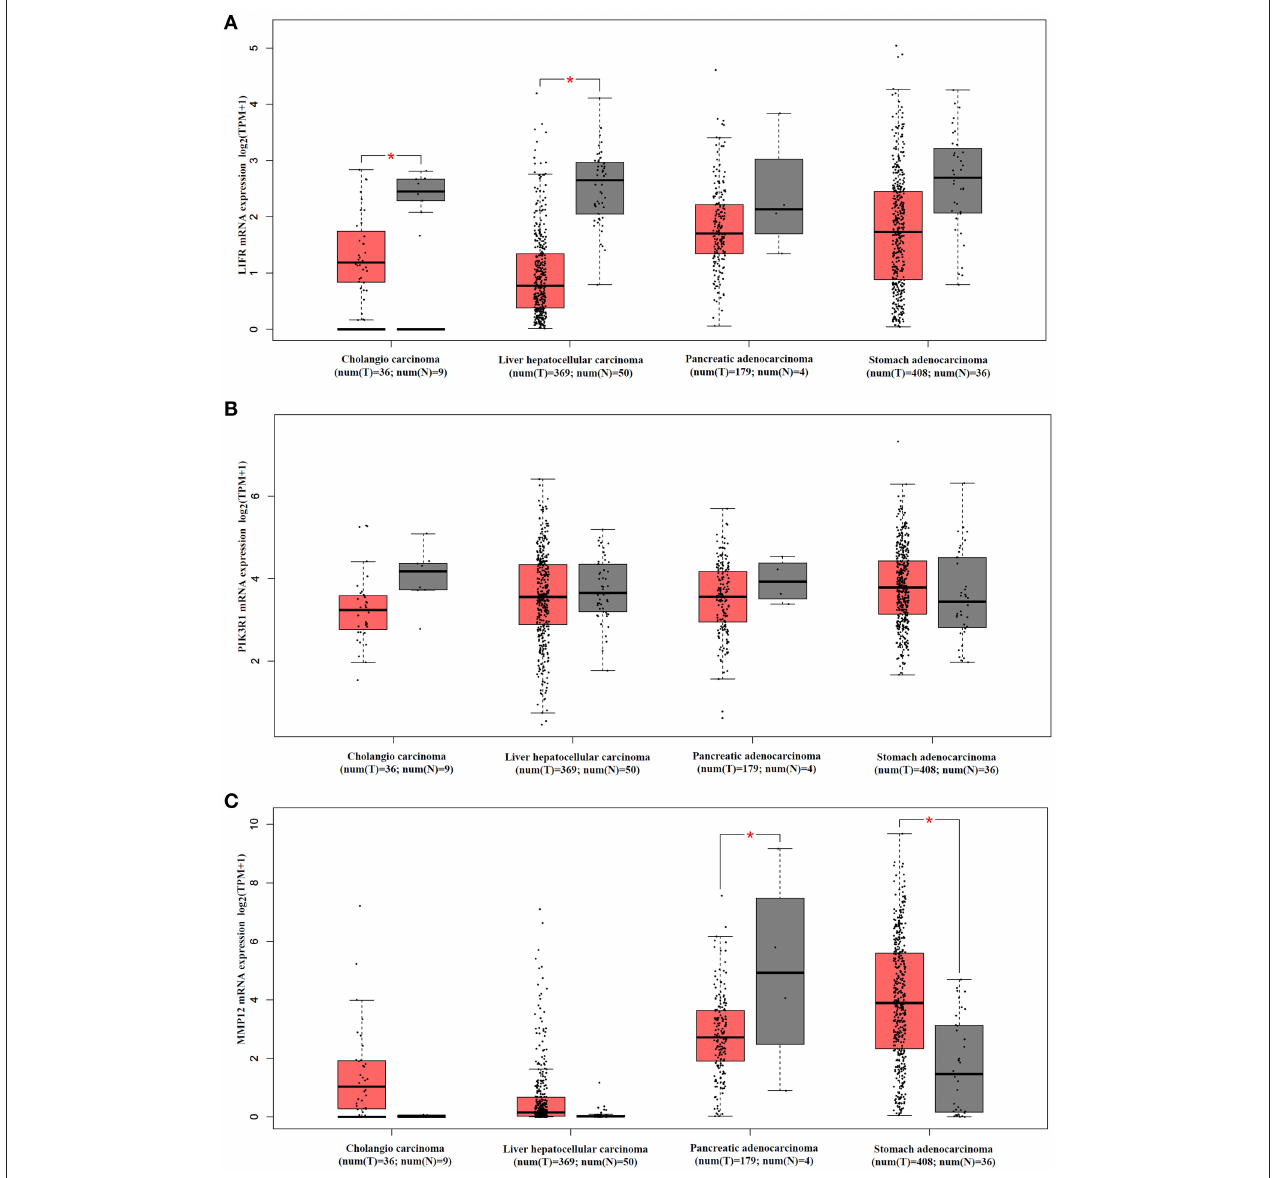
FIGURE 6 | mRNA expression profile of LIFR , PIK3R1 and MMP12 in cholangio carcinoma, liver hepatocellular carcinoma, pancreatic adenocarcinoma and stomach adenocarcinoma. Expression profile of LIFR (A) , PIK3R1 (B) , and MMP12 (C) across all tumor samples and paired normal tissues. * P <